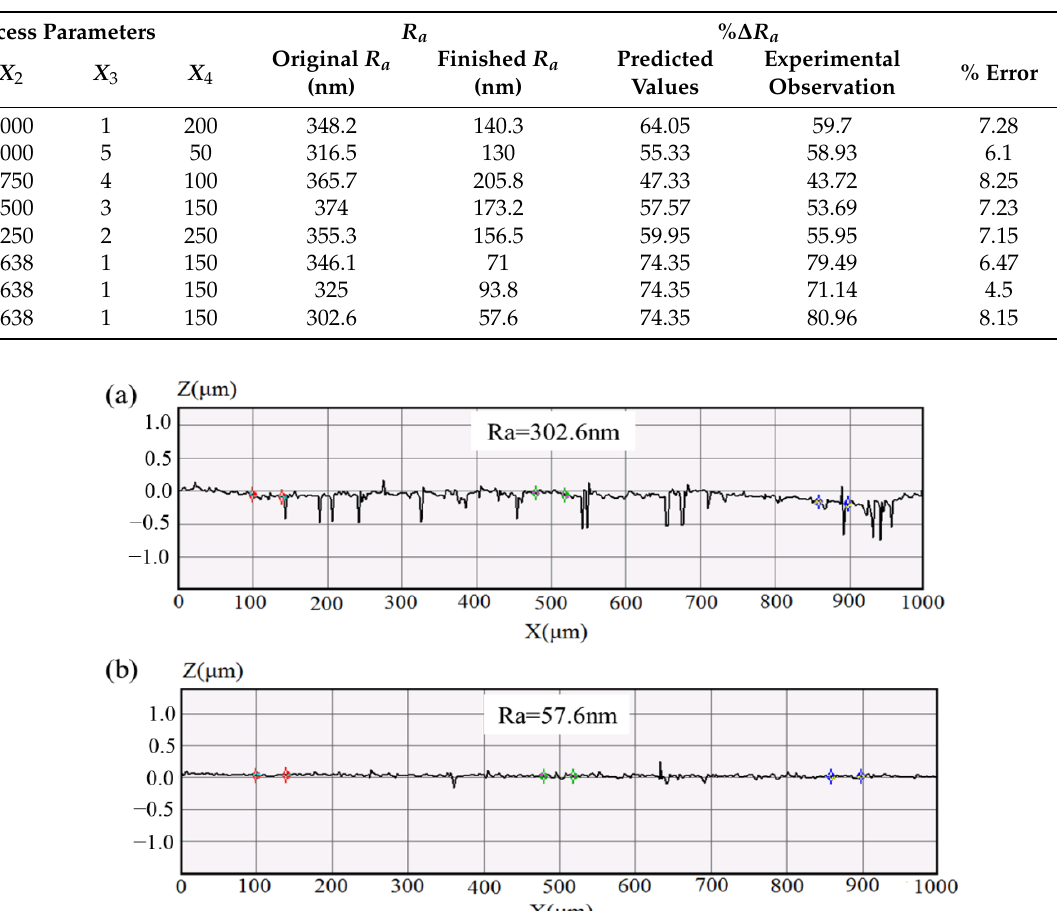
Table 7. Validation details of statistical model.